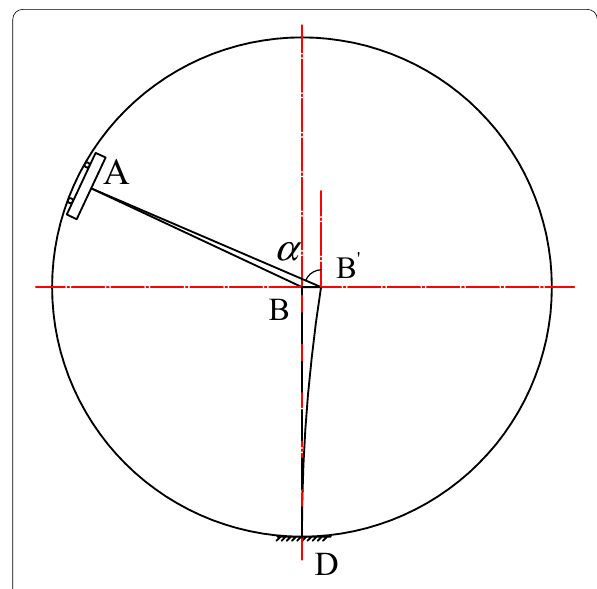
Figure 9 Model with deformation of the